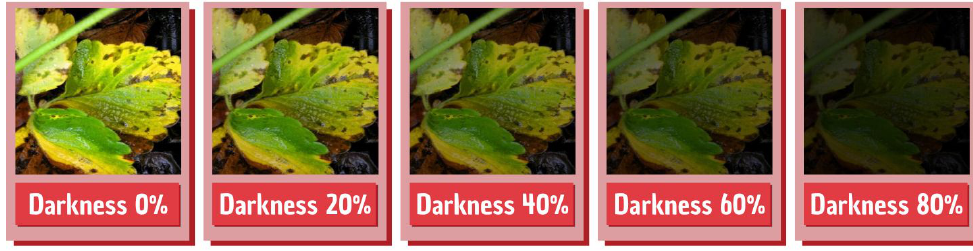
Figure 24. Brightness adjustments performed on the dataset.